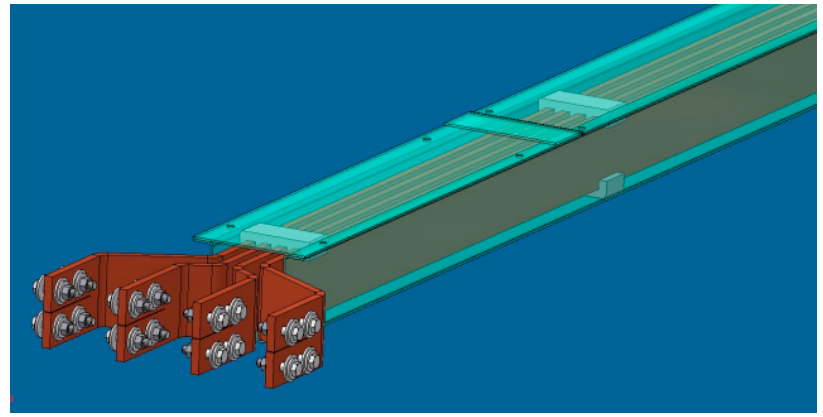
Figure 1. Three phase bus duct with a neutral busbar manufactured by the Holduct company (Myslowice, Poland) [5].